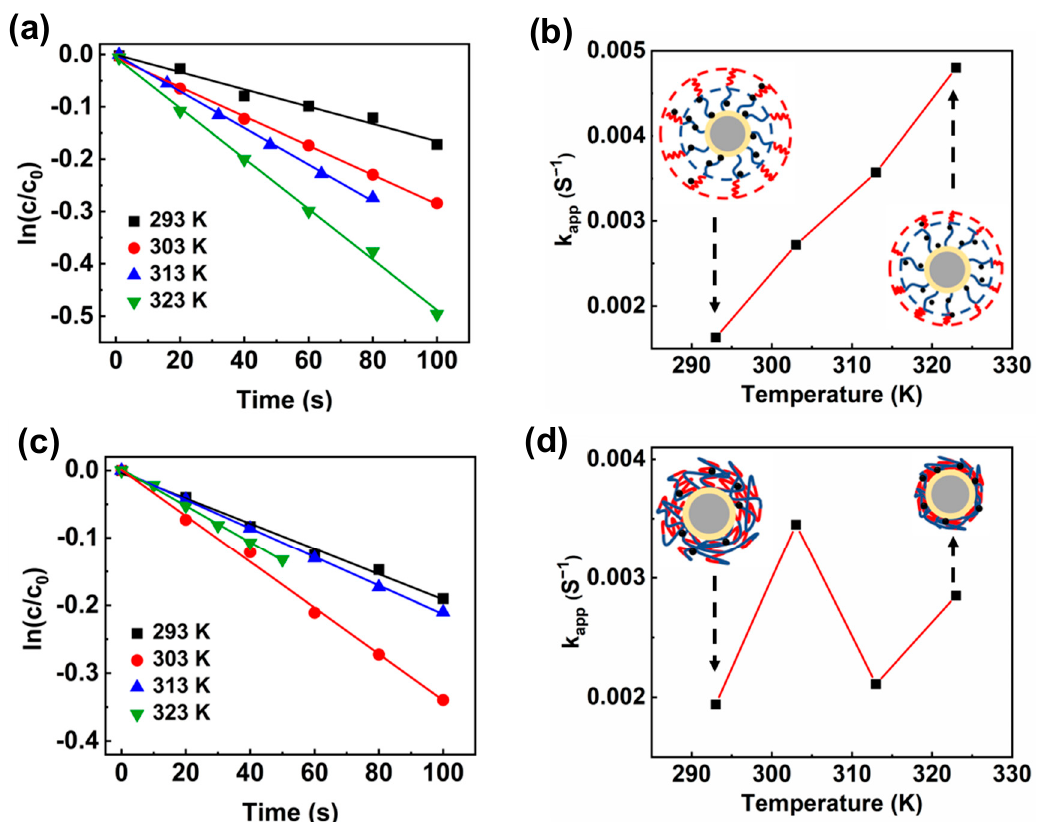
Figure 8. Kinetics of the reduction of 4-NP and relationship between apparent kinetic constant (k app ) and temperature (K) of ( a , b ) PSV@PSS-b-PNIPA@Ag and ( c , d ) PSV@PNIPA-b-PSS@Ag.